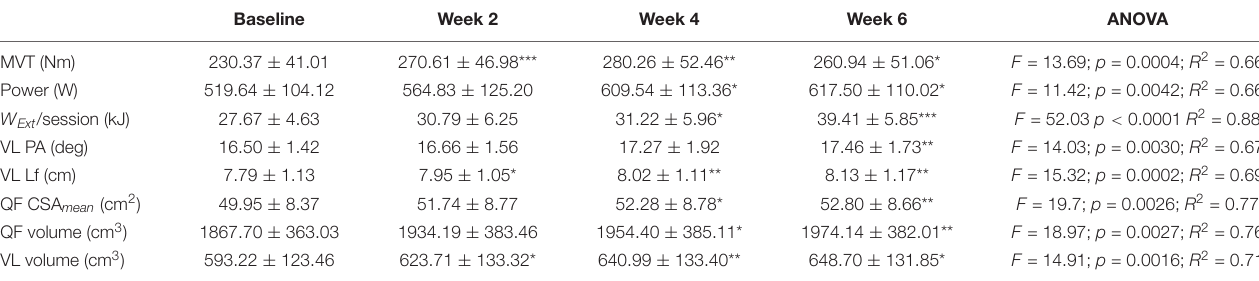
TABLE 1 | Time-course of the muscle morphological and functional adaptations to a 6-week plyometric